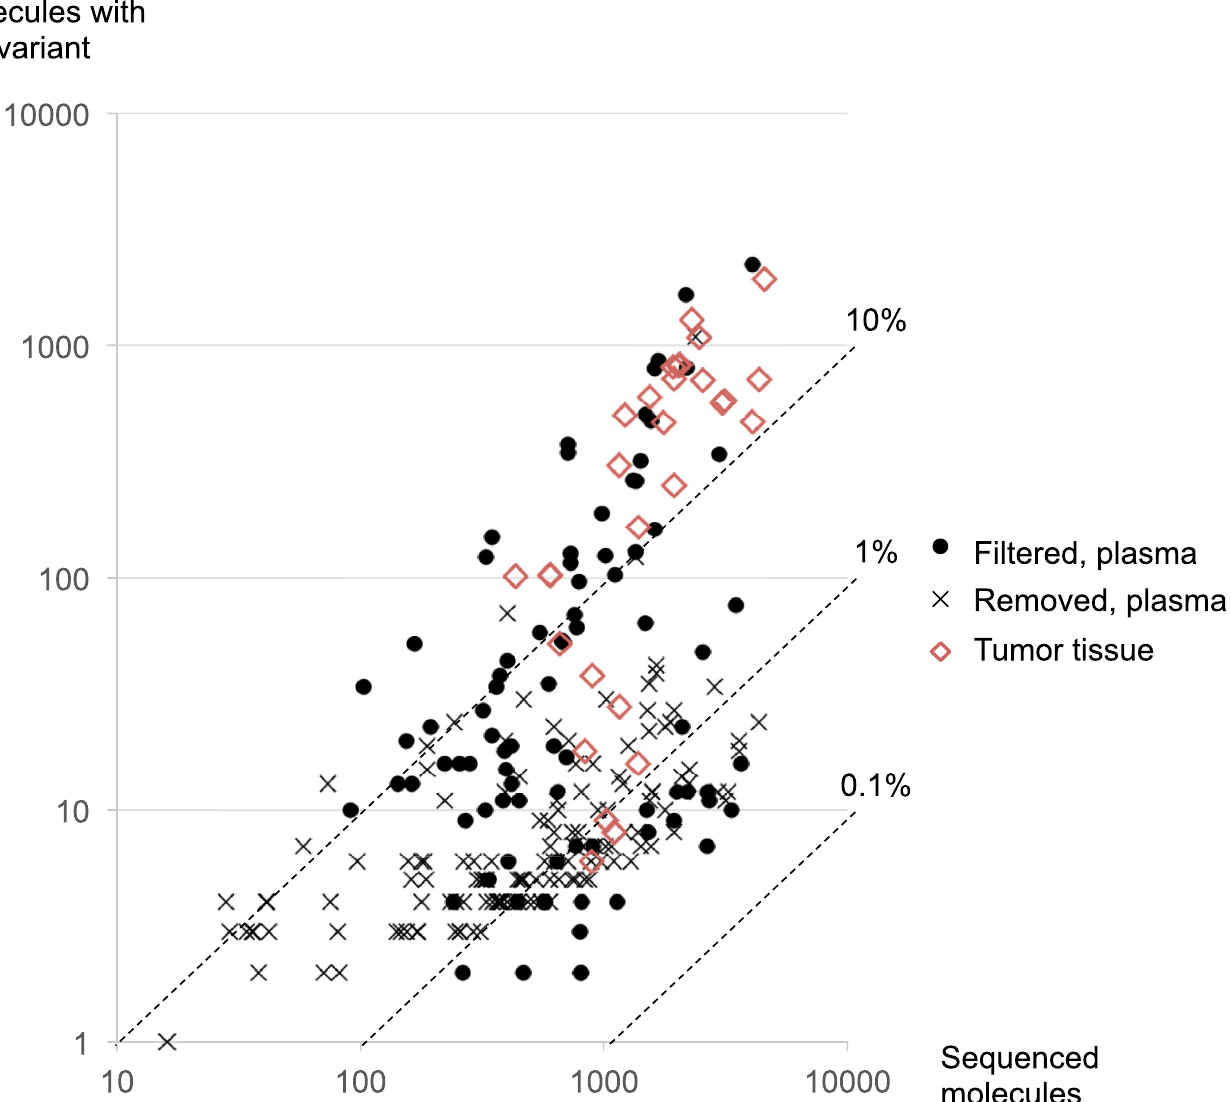
Fig 3. Distribution of the sequenced molecules. The x-axis shows the number of sequenced molecules, and the y-axis shows the number of molecules in which a variant was detected. The diagonal broken lines indicate variant allele frequencies. Closed circles: filtered variants; Cross marks: variants removed by CV78 filtering; Diamonds: variants in tumor